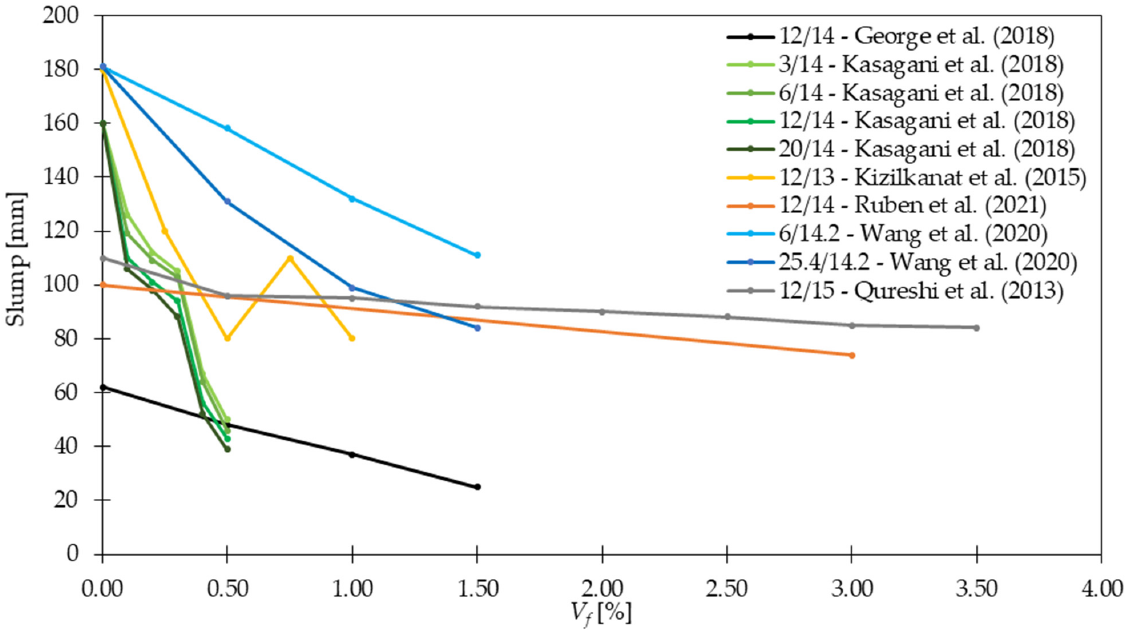
Figure 4. Influence of V f on concrete slump for different fiber geometry l f /d f [16,17,22,27,29,50].